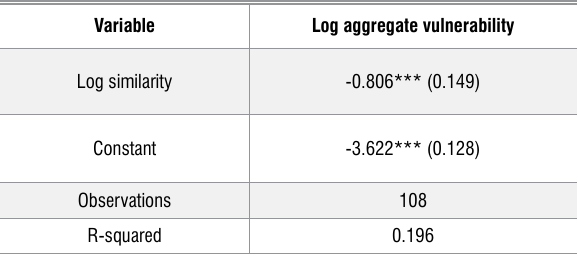
Figure 5: Aggregate banking sector vulnerability from 2010 to 2020. The y -axis has the share of banking sector equity wiped out by spillover losses, e.g. 4% in December 2010.